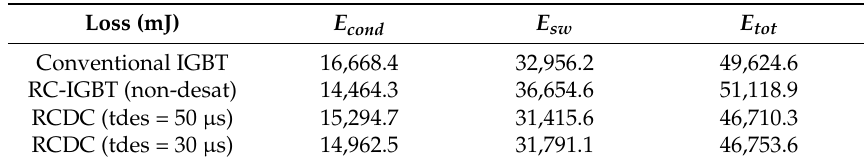
Table 2. Losses Distribution of the PWM Rectifier.